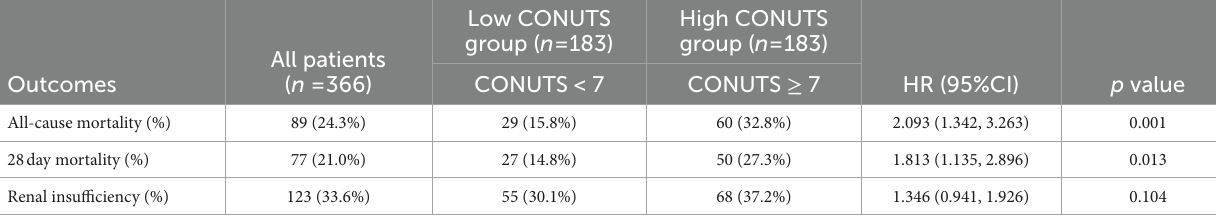
TABLE 2 Short-term complications and outcomes in the propensity score matched